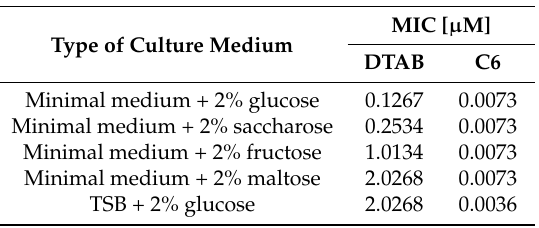
Table 1. The value of of minimal inhibitory concentration of monomeric n